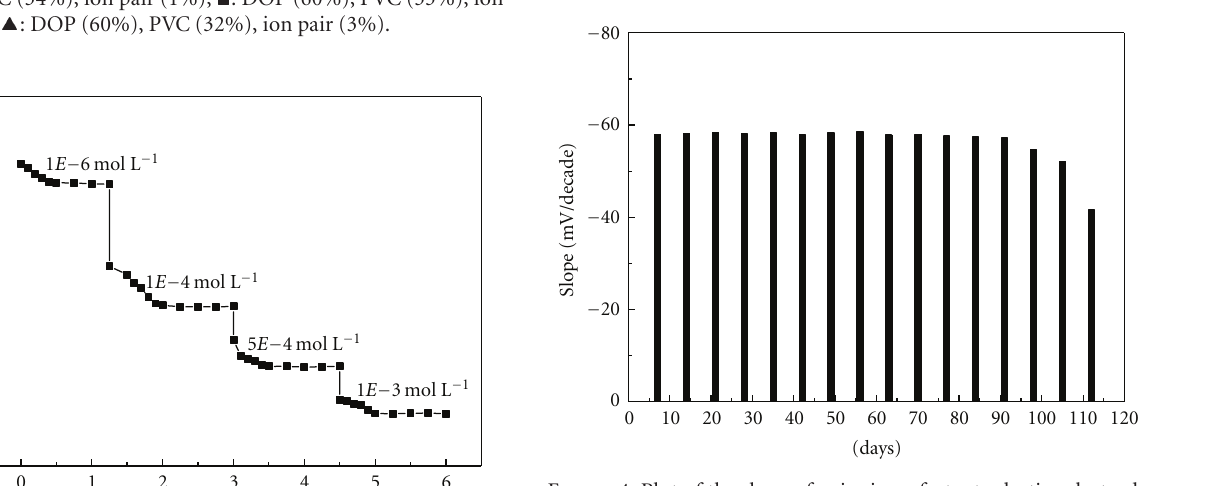
Figure 4: Plot of the slope of anionic surfactant selective electrode in the presence of SDS versus time